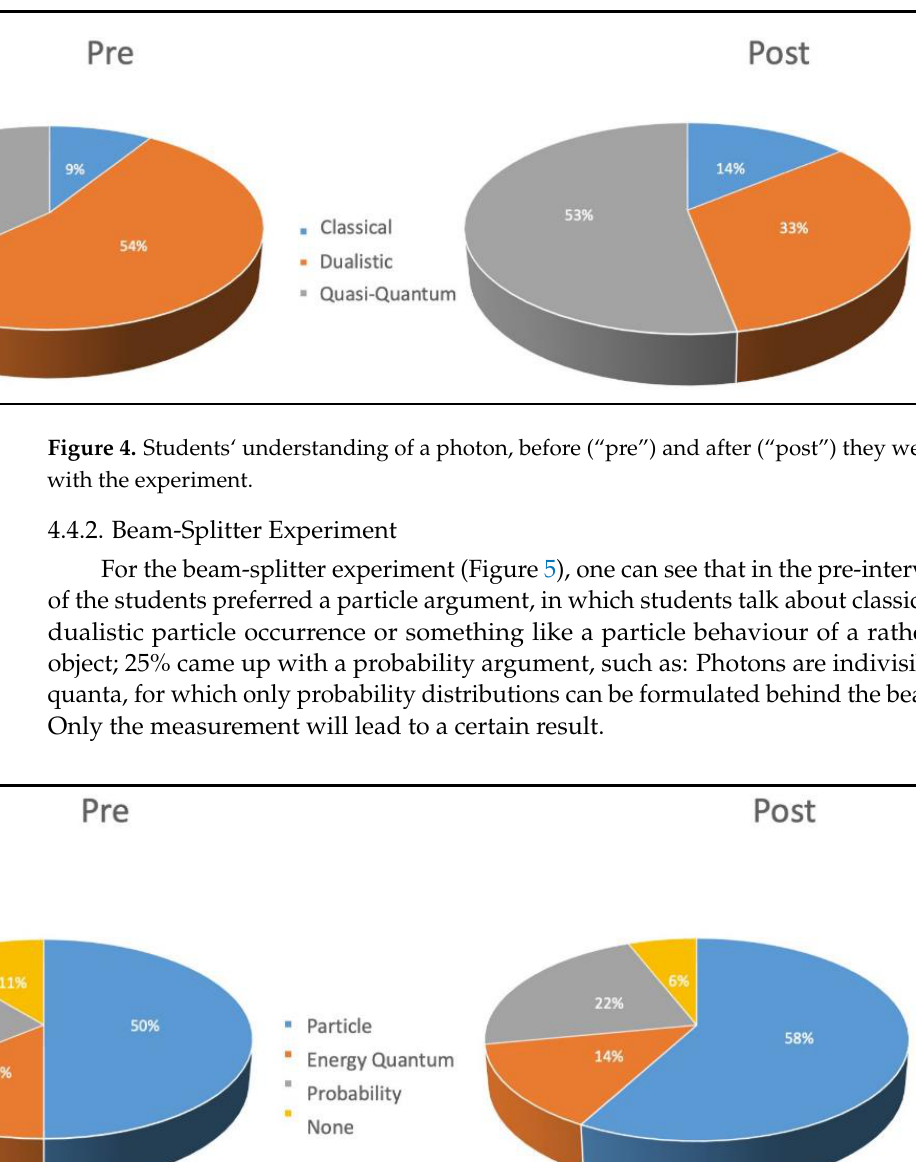
Figure 4. Students‘ understanding of a photon, before (“pre”) and after (“post”) they were en- gaged with the experiment.